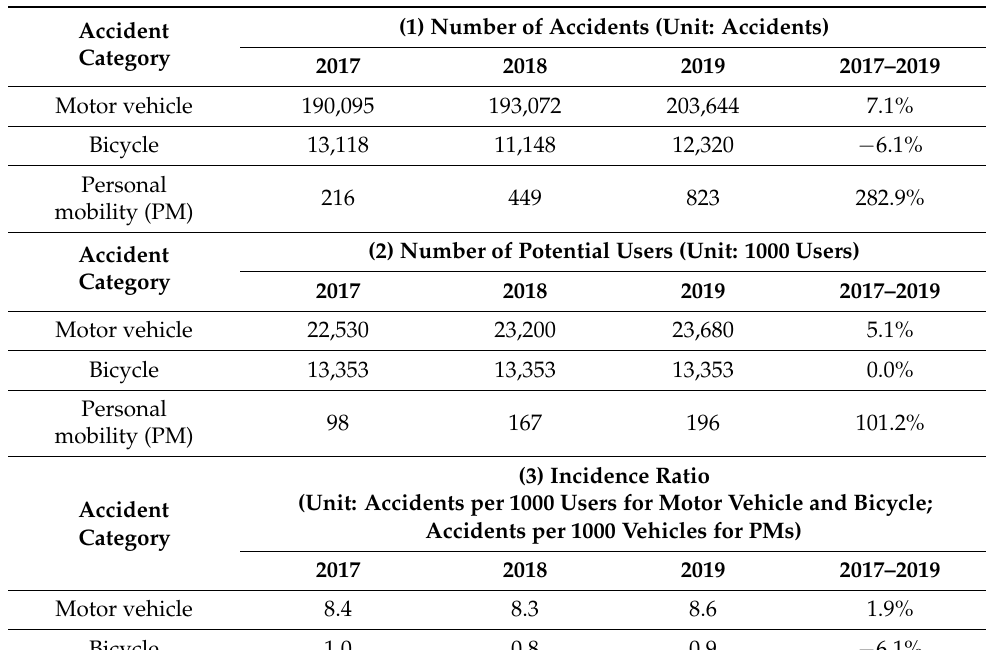
Table 2. Accident